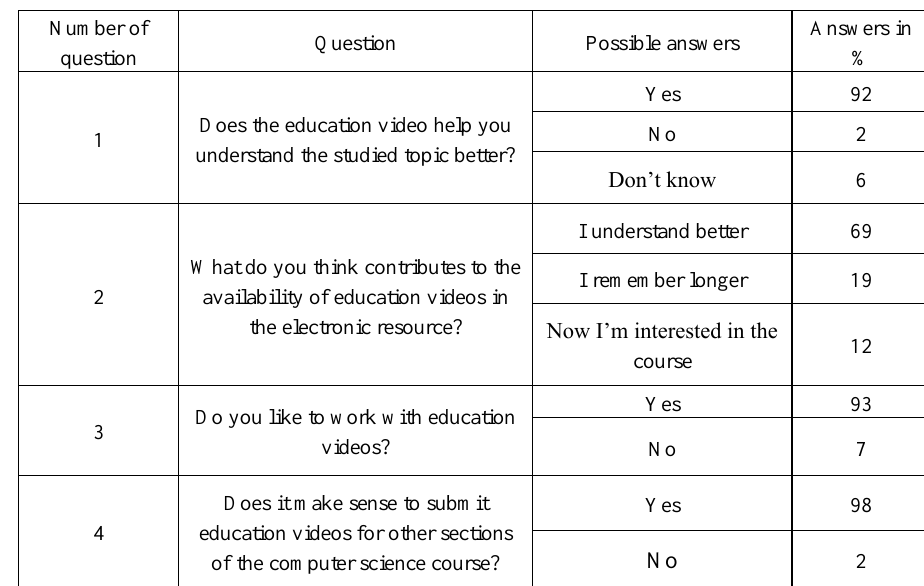
Table 2. Results of students’